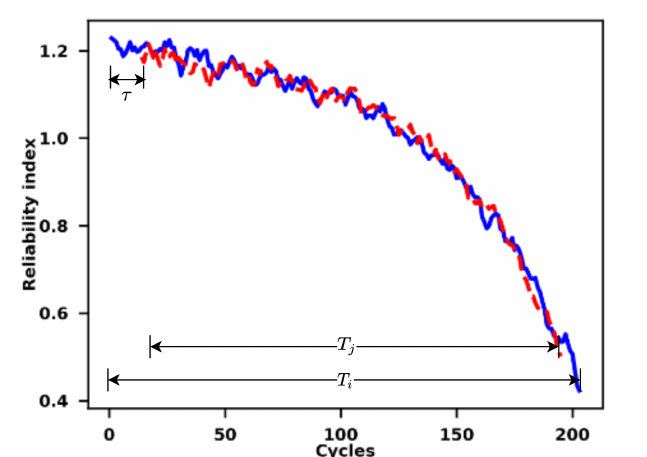
Figure 2. Illustration of the similarity matching process of relaibility